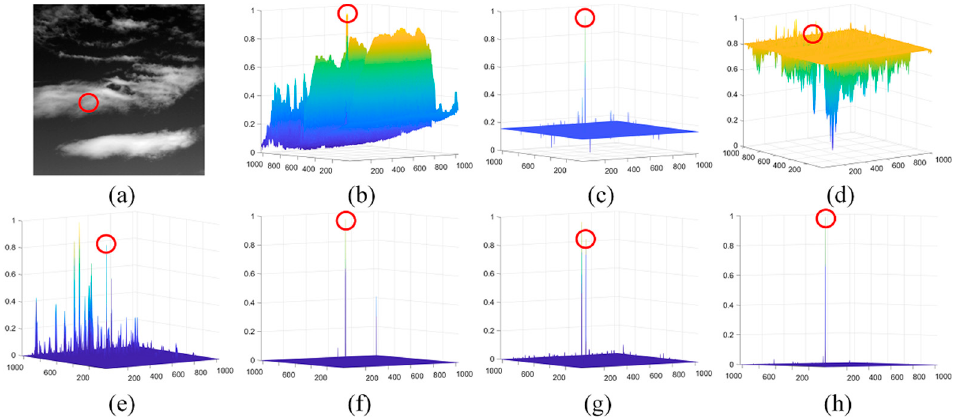
Figure 12. The detection results of different methods on S3: ( a ) the 1st image in S3 and ( b – h ) normalized 3-D mesh obtained by the LCM [18], IPI [10], MCPM [19], LIG [22], PSTNN [12], FKRW [15], and the proposed method, respectively.